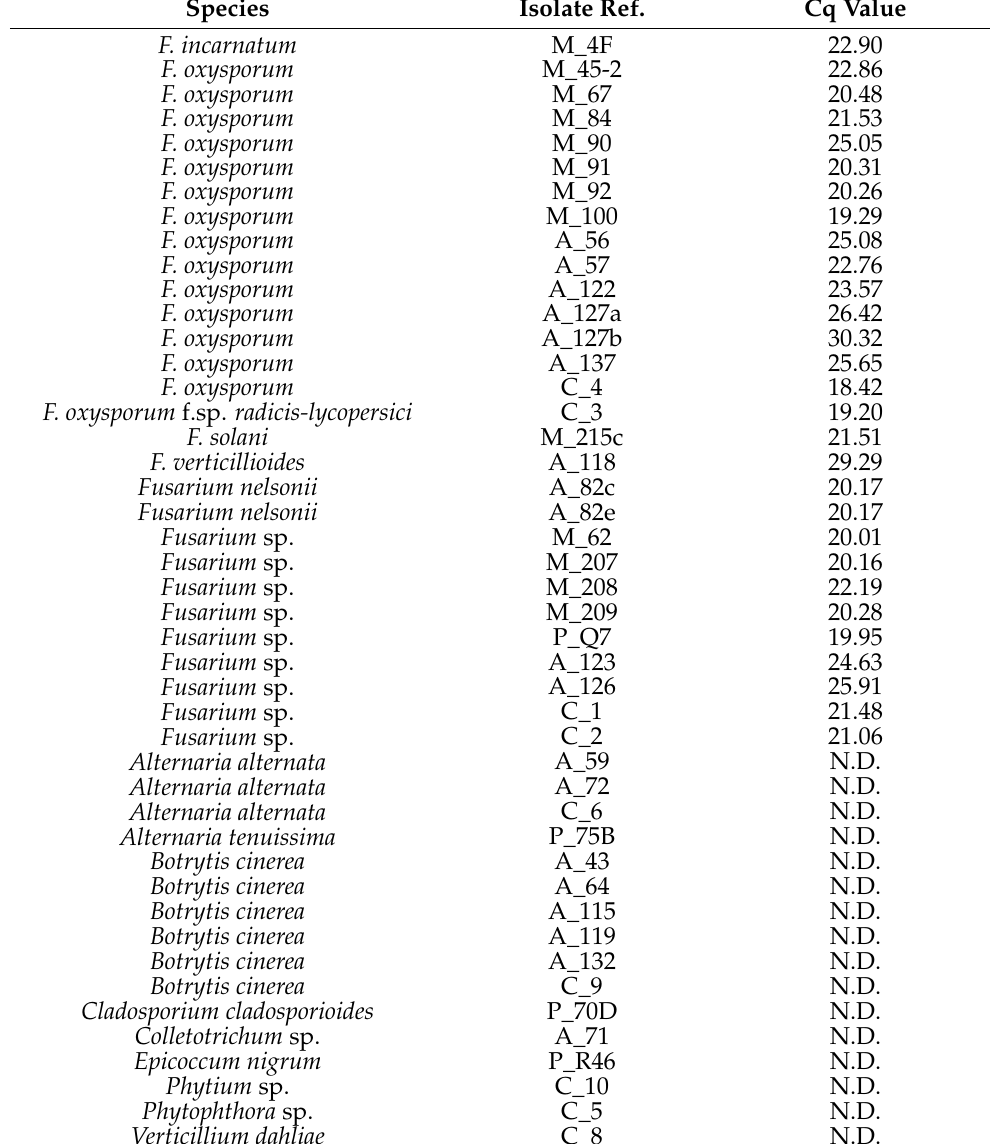
Table 1. List of isolates of Fusarium spp. and other fungal isolates used to test species specificity using the Fusarium spp.-specific qPCR assay. Data are expressed as quantification cycle (Cq) values, using 100 ng of gDNA as template. N.D.: not detected. Species Isolate